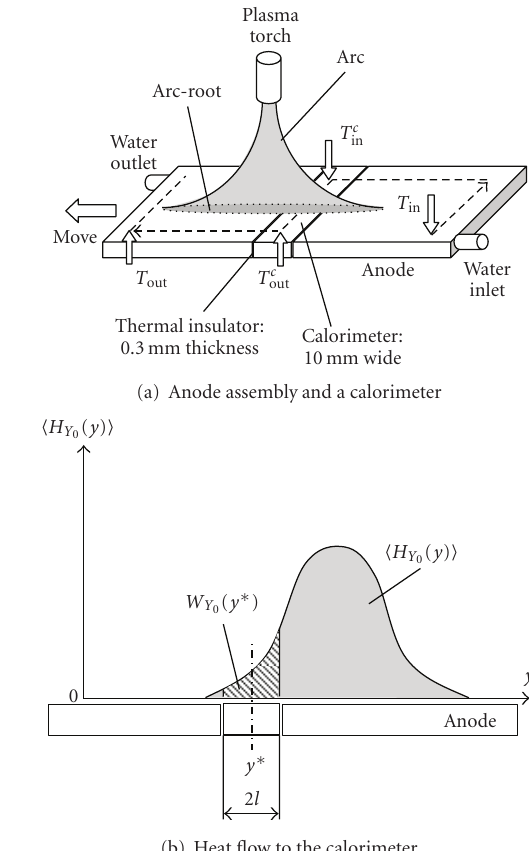
Figure 6: Coil current with rectangular waveform.